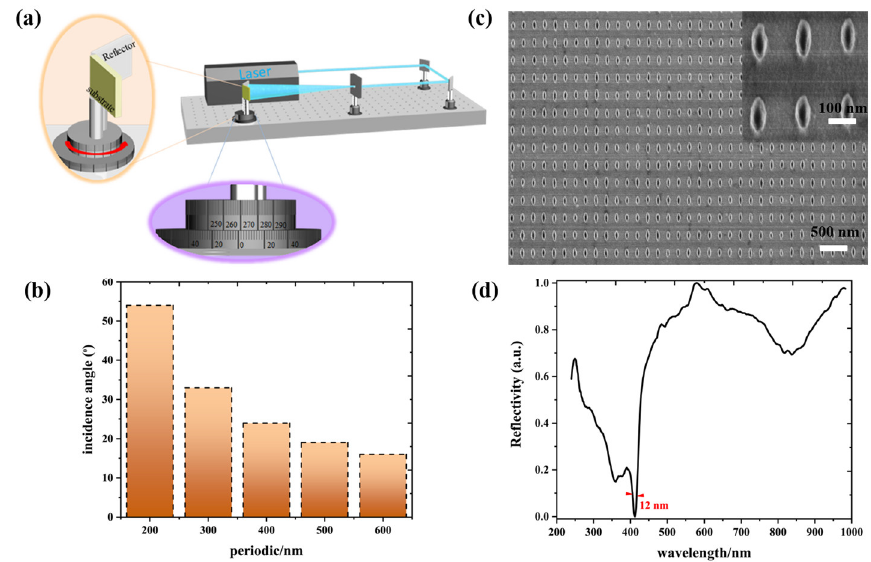
Figure 6. ( a ) Schematic of the LIL technology. Reprinted with permission from Ref. [23]. Copyright 2019 Royal Society of Chemistry. ( b ) The relationship between periods and incidence angles for wafer-scale plasmonic arrays. ( c ) Typical SEM image of a low-symmetry Al metasurface with 200 nm in Px and 400 nm in Py. ( d ) Reflectance spectra of a low-symmetry Al metasurface with 200 nm in Px and 400 nm in Py at normal illumination.